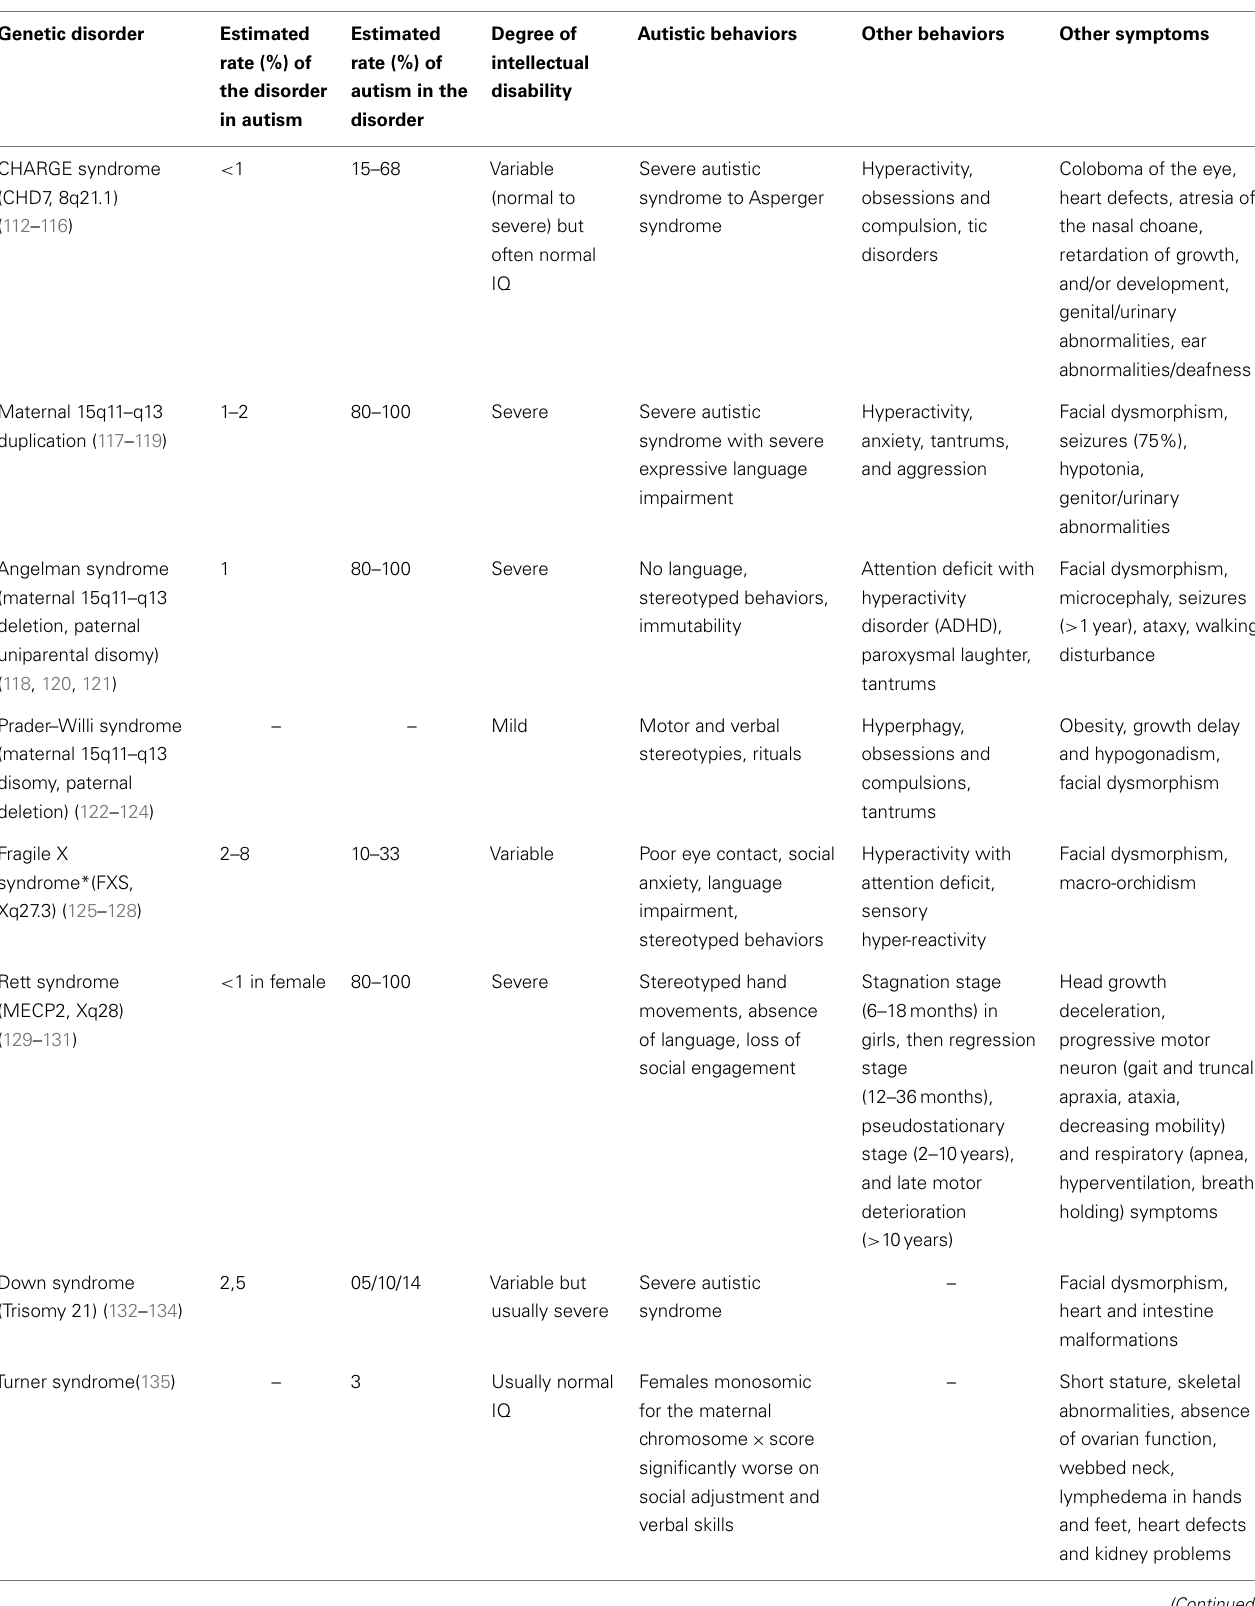
Table 2 | Genetic disorders with epigenetic mechanisms associated with autistic syndrome